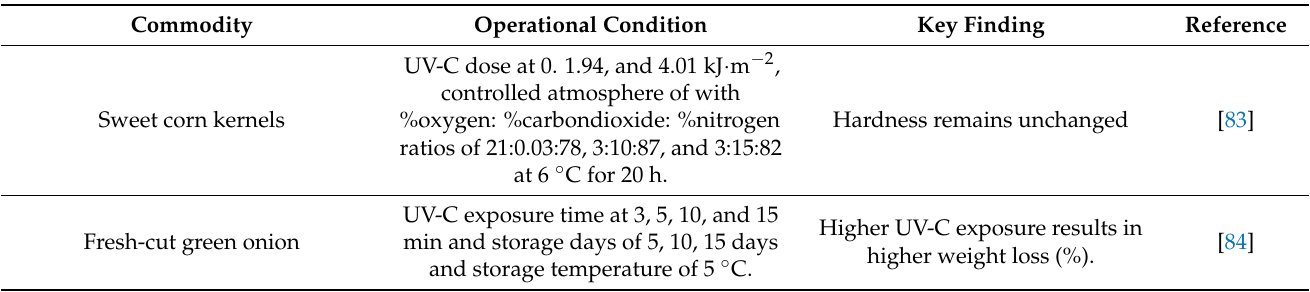
Table 1. Mechanical and related characteristics of UV-C exposed plant products.